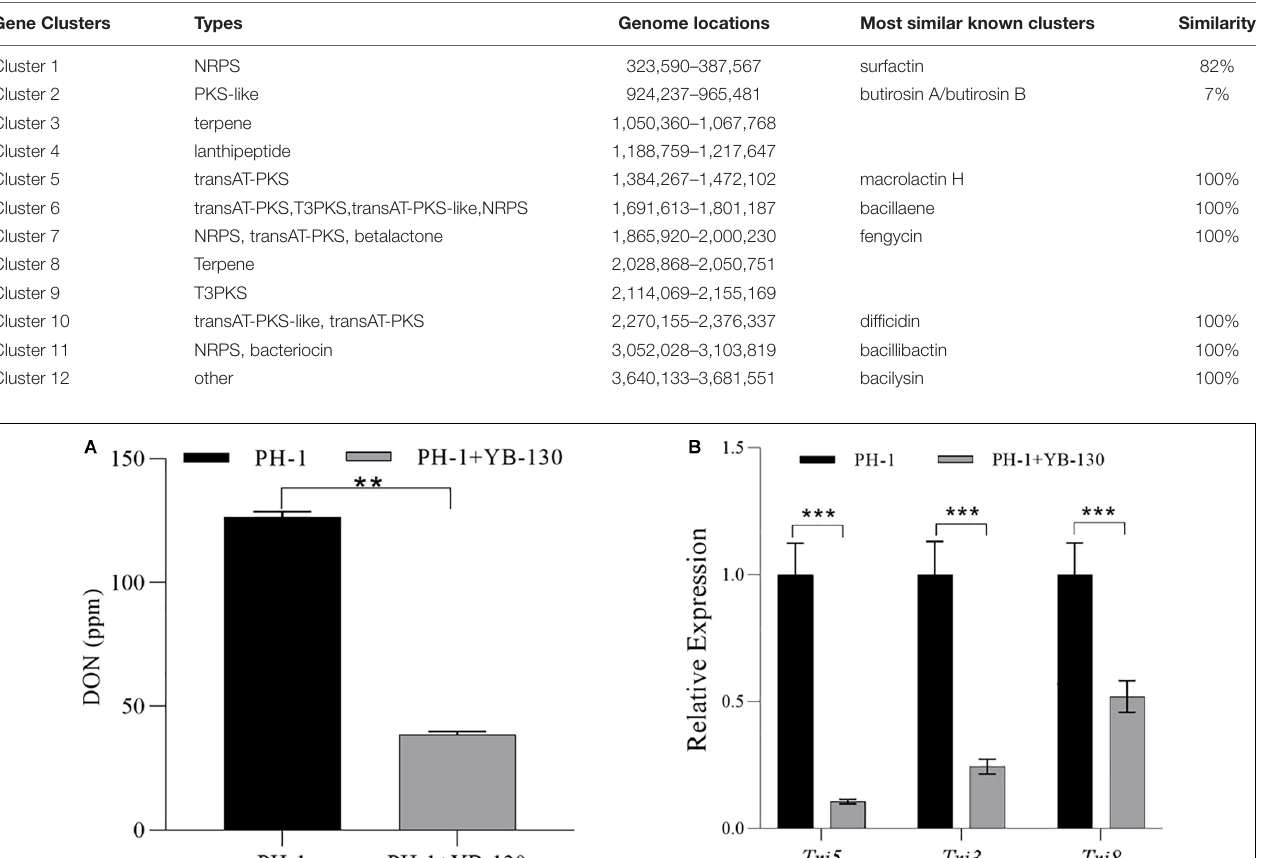
TABLE 1 | List of the putative gene clusters encoding for secondary metabolites by antiSMASH in strain YB-130 genome.